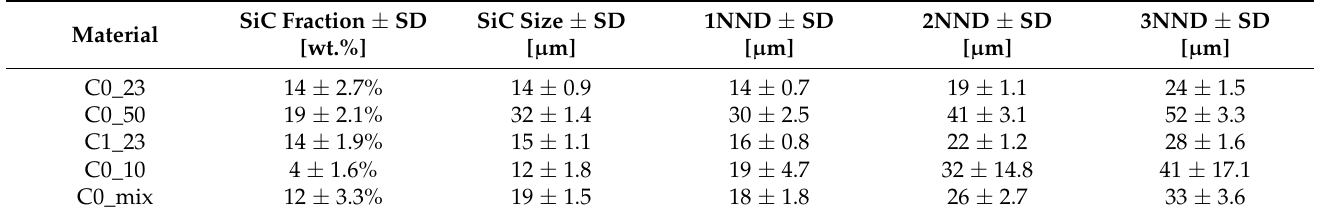
Table 3. Results of the quantitative image analysis performed using the ImageJ and MATLAB soft- ware. SD = standard deviation.